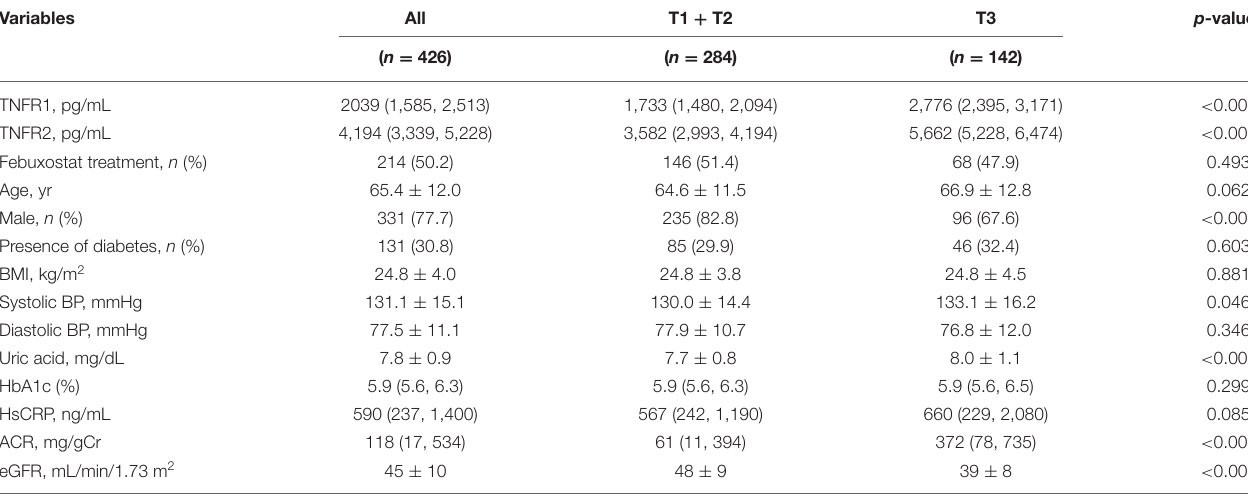
TABLE 1 | Characteristics of the study patients according to the circulating TNFR2 levels. Variables